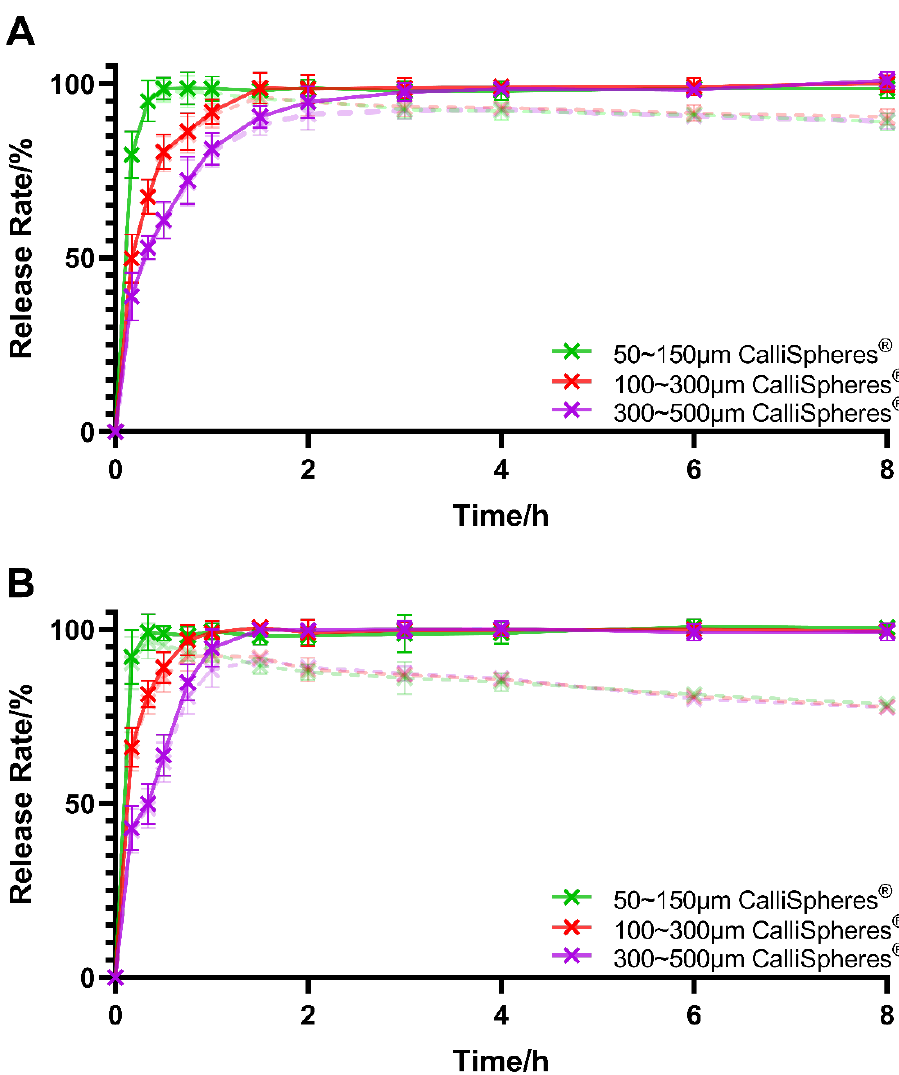
Figure 3. IDA in vitro release profiles in: ( A ) PBS; and ( B ) PBS + 10% FBS. The dashed lines are the release rate before correction of drug degradation ( n = 3).